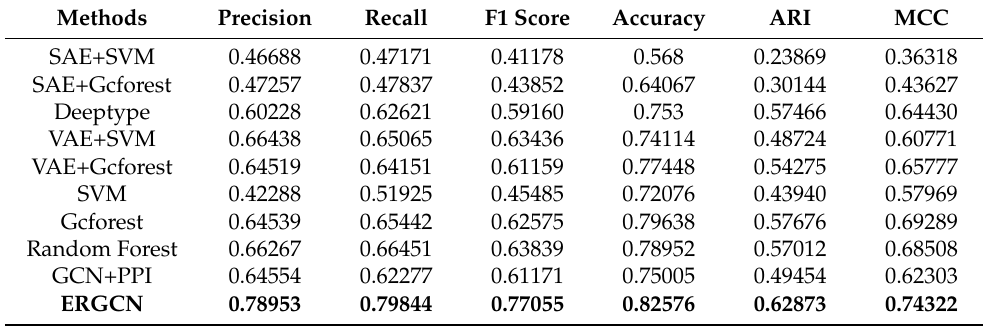
Table 1. The external evaluation metrics of every model on BRCA dataset.